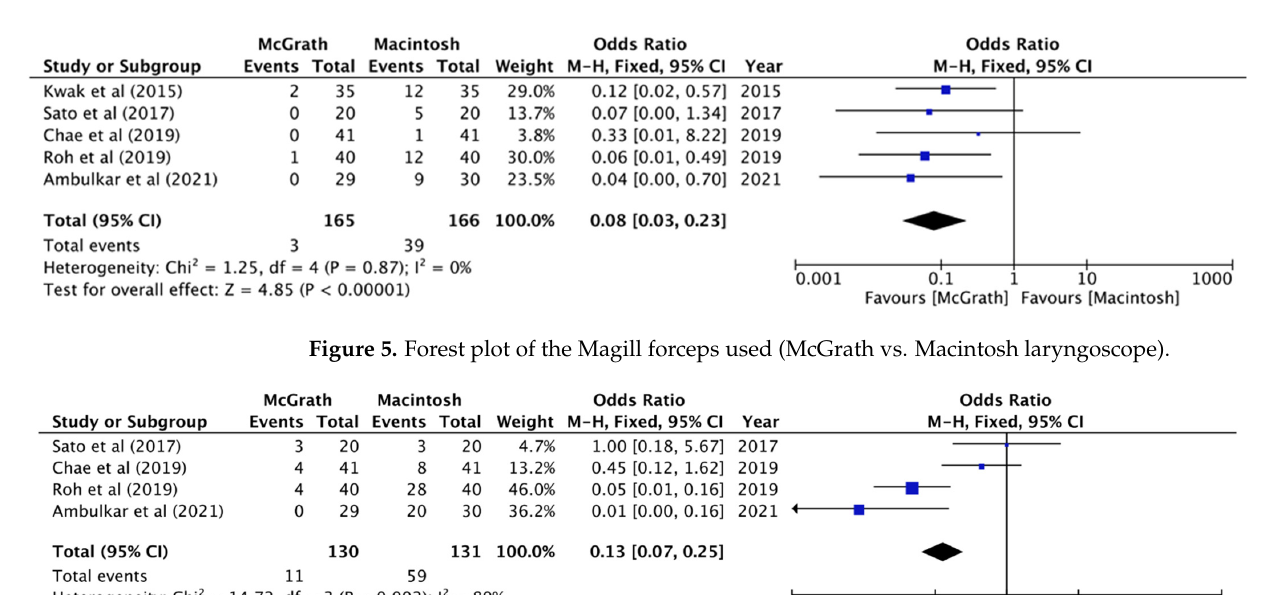
Figure 6. Forest plot of the external laryngeal pressure maneuver used (McGrath vs. Macintosh laryngoscope).